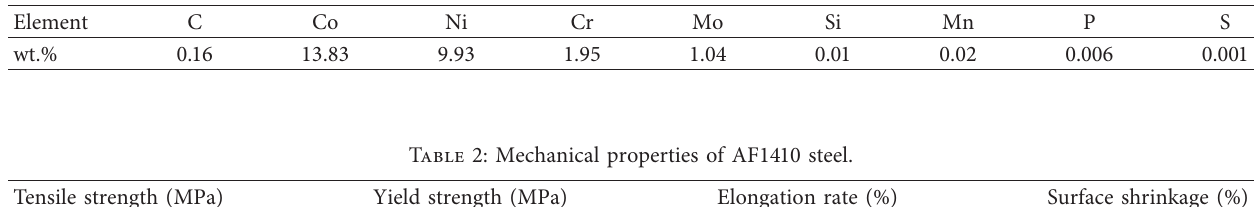
Table 1: Chemical composition (wt.%) of AF1410 steel.